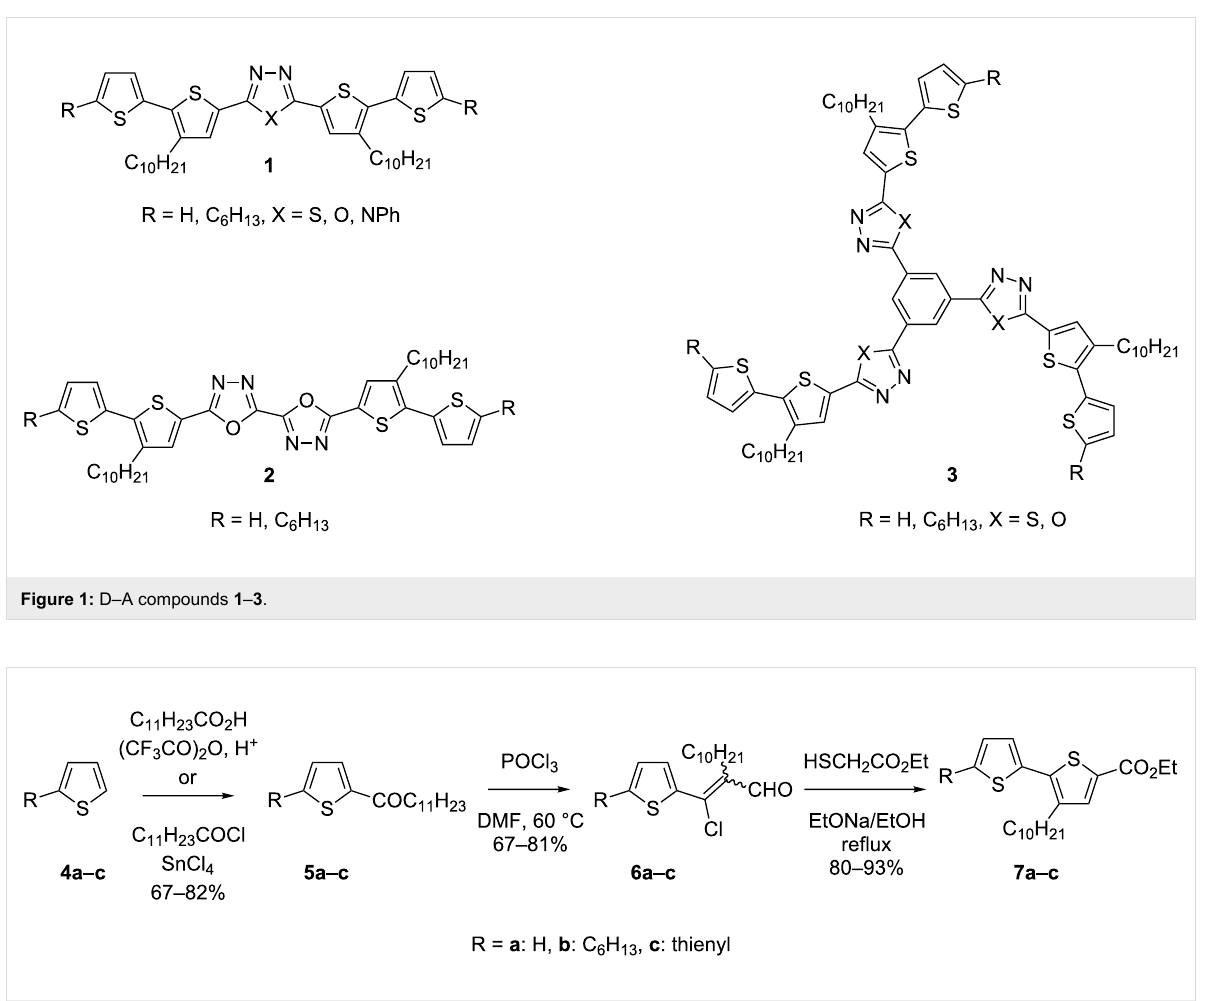
Scheme 1: Synthesis of 3-decyl-2,2'-bithiophene-5-carboxylic acid ethyl esters 7a–c